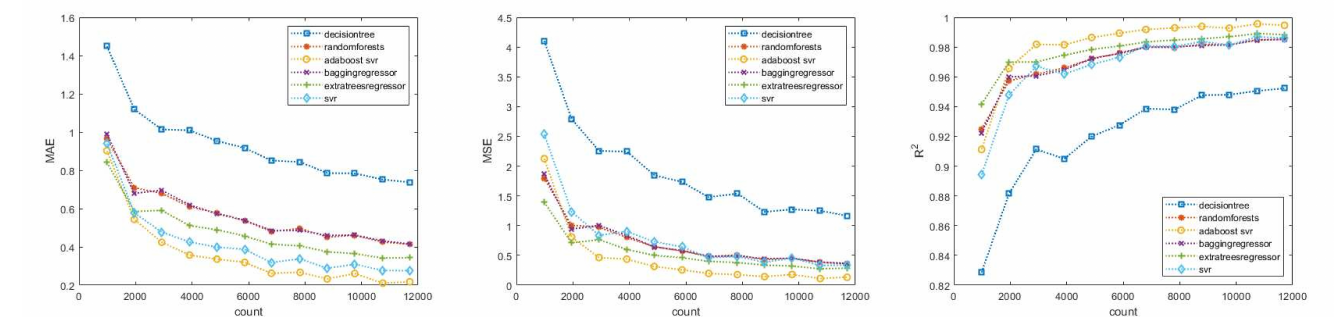
Figure 1. MAE, MSE, and R 2 of theoretical model.